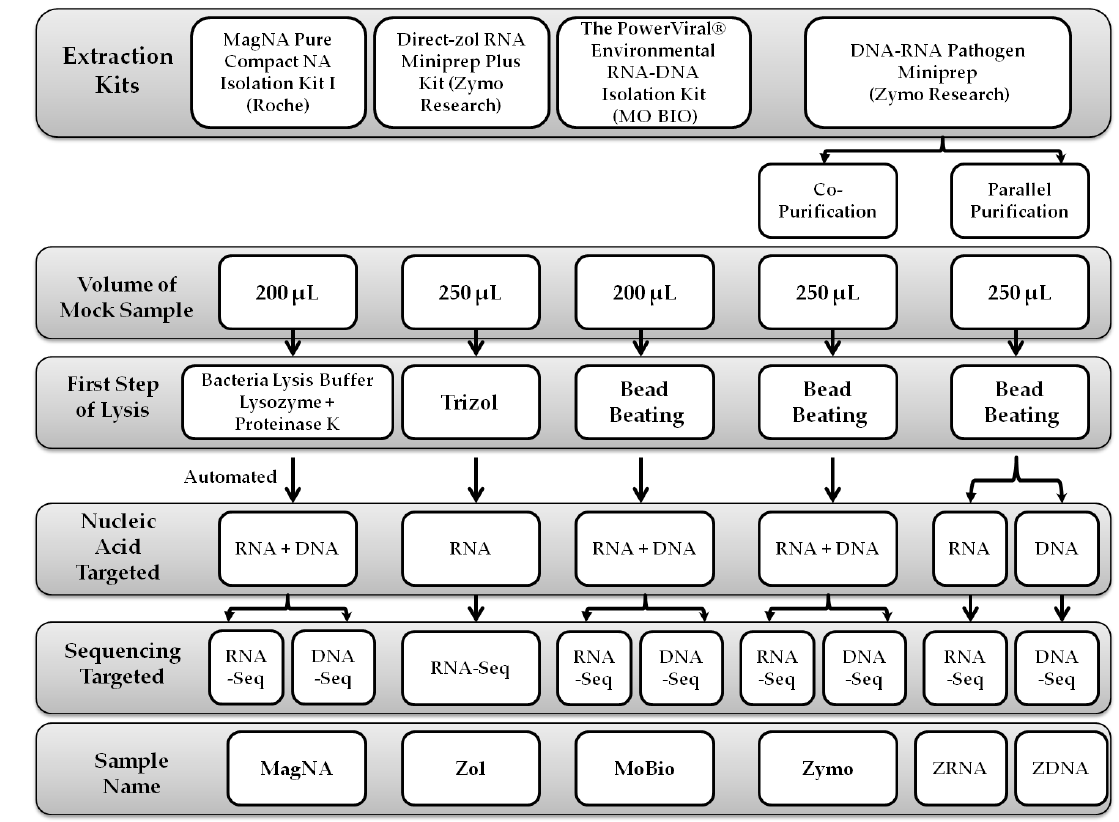
Figure 1. Schematic presentation of the extraction protocols used for comparison in this study. DNA -Seq stand for DNA sequencing and RNA-Seq stand for RNA sequencing.